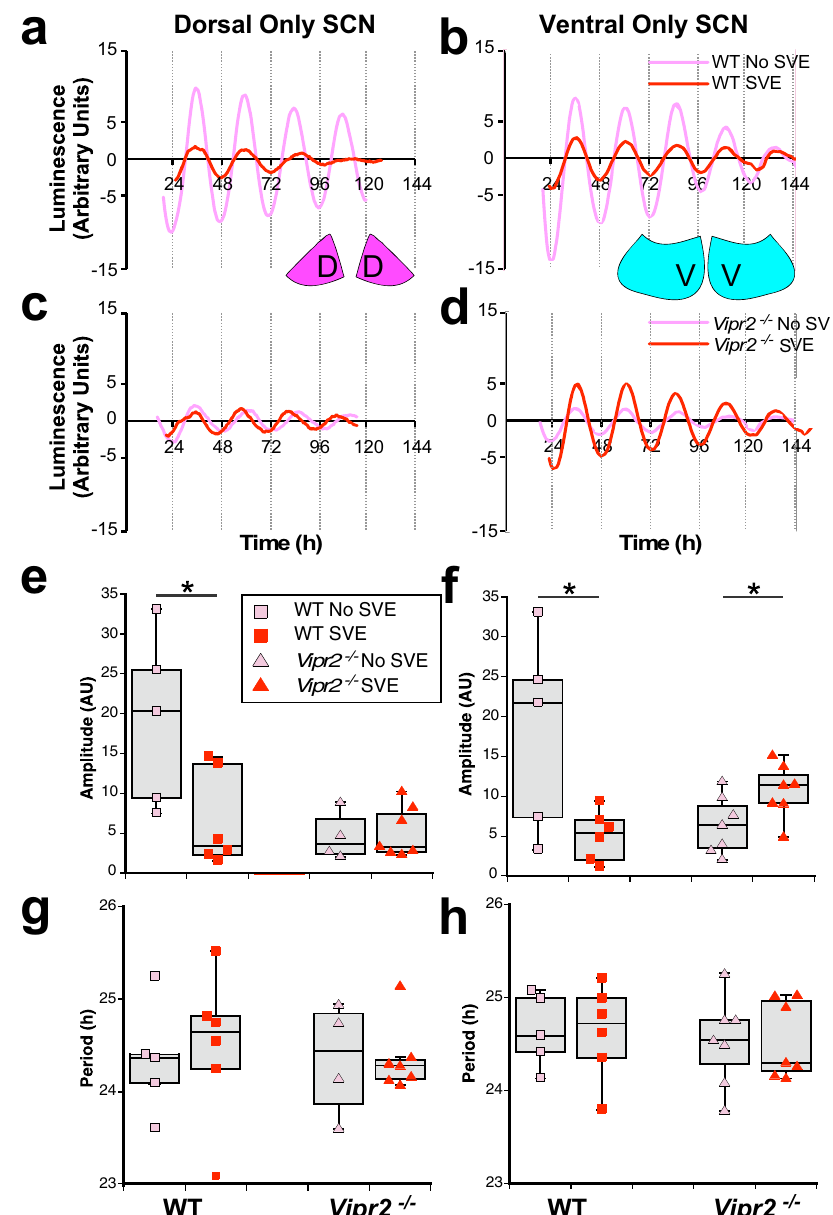
Fig. 6 SVE improves molecular rhythms in the ventral SCN in microdissected explants from Vipr2 − / − mice. a – d PER2::LUC bioluminescence amplitude was signi fi cantly reduced by SVE in the WT dorsal only SCN (doSCN; pink fi lled D diagram insert) and ventral only SCN (voSCN; blue fi lled diagram insert) microdissected mini slices (dorsal: 19.2 ± 4.8 vs. 6.5 ± 2.4 arbitrary units, p = 0.018; ventral: 18.0 ± 5.6 vs. 5.0 ± 1.3, p = 0.017) but was boosted by SVE in the Vipr2 − / − voSCN (6.4 ± 1.4 vs. 10.7 ± 1.3; p = 0.041, all t tests). SVE did not alter amplitude in the Vipr2 − / − doSCN (4.6 ± 1.5 vs. 5.1 ± 1.2; p > 0.05). Period ( g , h ) was not altered by SVE in either part of the SCN for either genotype. Gray shaded boxes in e – h represent the interquartile distance between the upper and lower quartile with the median plotted as a horizontal line within the box. Whiskers depict the lower quartile − 1.5 × interquartile distance and upper quartile + 1.5 × interquartile distance. Individual data points are overlaid. * p = 0.05. Symbol color coding in f – h is as shown in e . a , c , e , g show data from doSCN. b , d , f , h show data from vo SCN. See also Figs. S3 and S4. D and V in diagram inserts label dorsal SCN and ventral SCN,